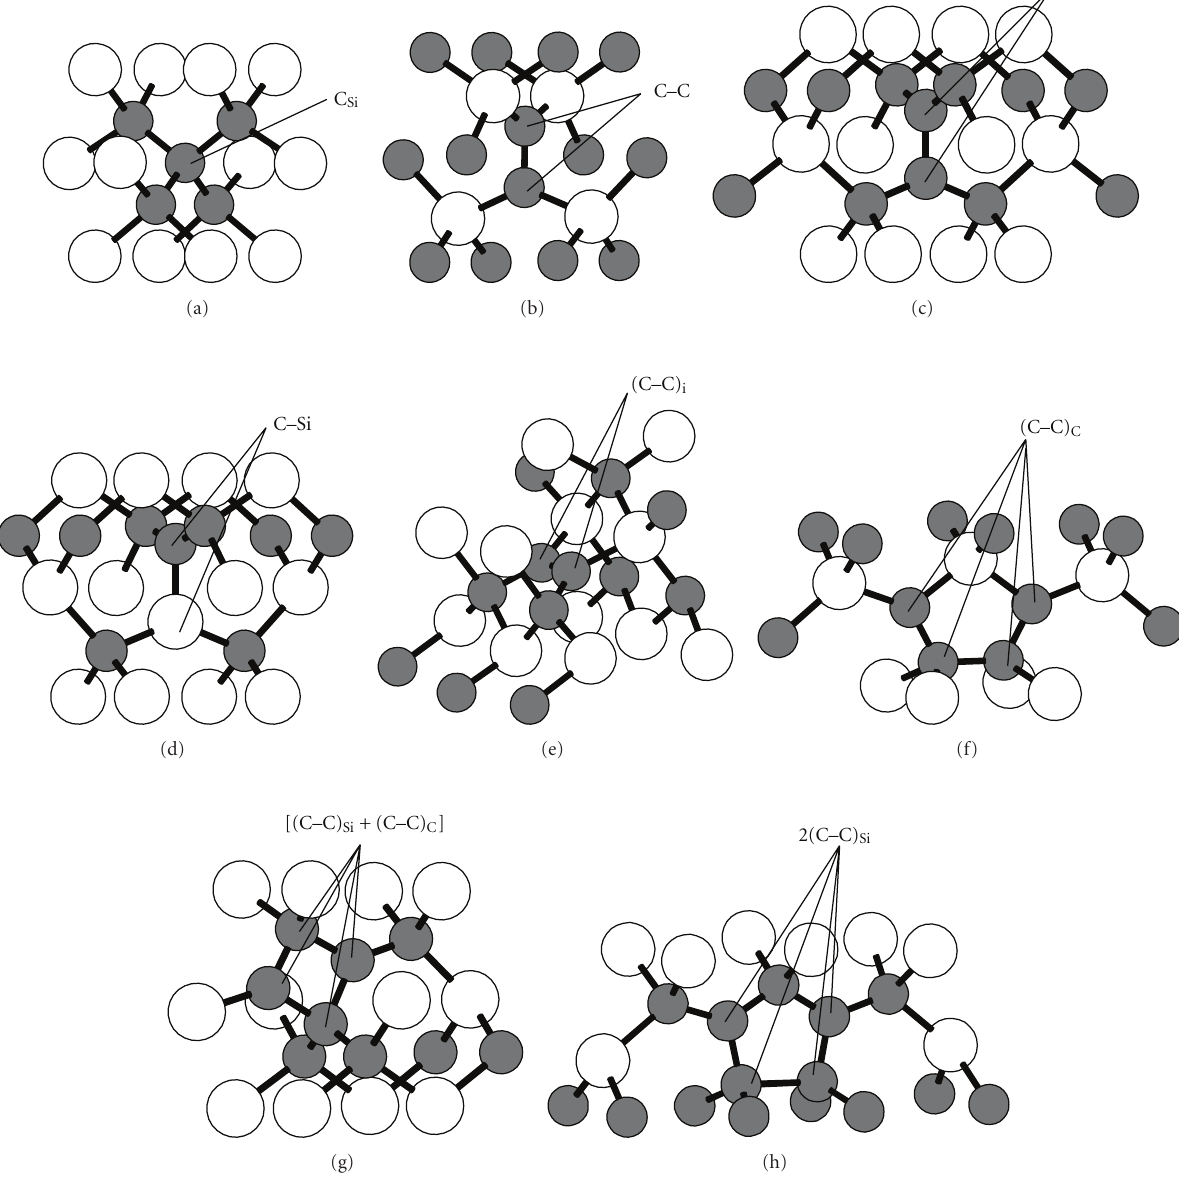
Figure 2: Optimized geometries of the carbon defects investigated in 3C–SiC bulk and in hydrogen-passivated [100] and [111] SiC NWs. (a) C Si , (b) C–C, (c) C–C Si , (d) C–Si, (e) (C–C) i , (f) 2(C–C) C , (g) ((C–C) Si + (C–C) C ), and (h) 2(C–C) Si